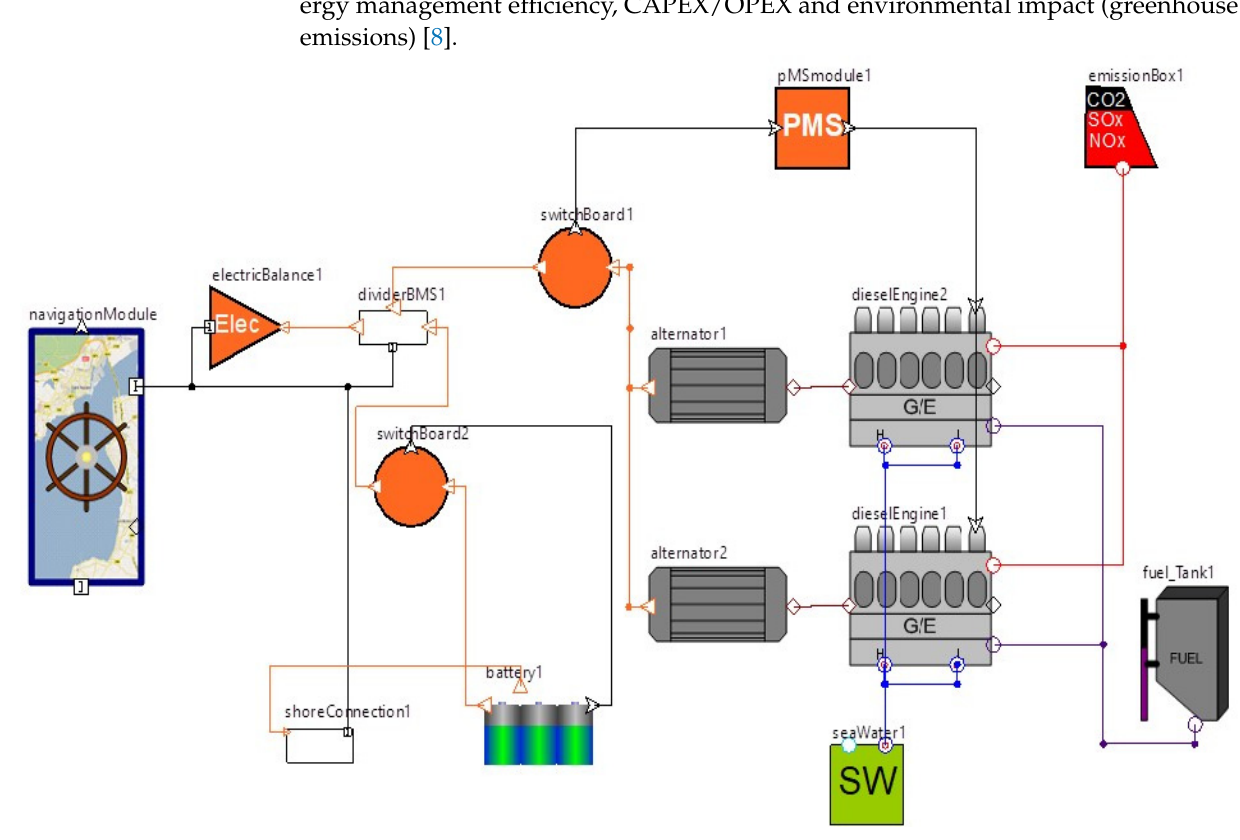
Figure 3. SEECAT ® —Simulation of Energy Management of Hybrid DE Ferry (BV-Elomatic). The COSMOS ® tool of Det Norske Veritas (DNV) (https://www.dnv.com/news/ dnv-gl-introduces-next-generation-energy-efficiency-methodology-6607, accessed on 6 November 2022) has been also integrated into the CAESES ® platform and has been used in other application cases.